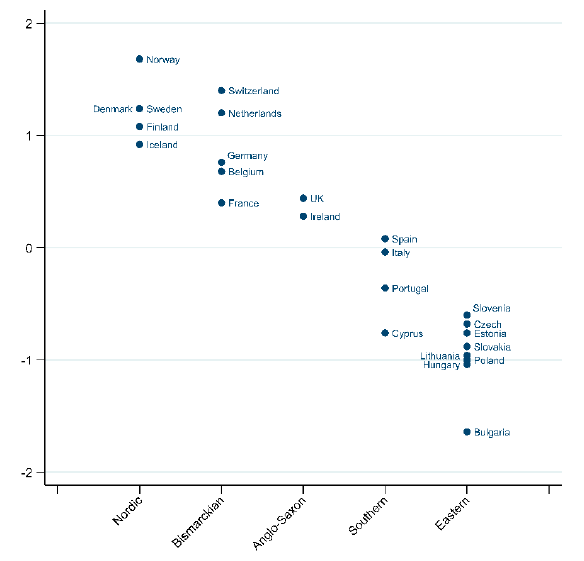
Figure 2. Country WS Index by WS Regime type for 24 European countries.